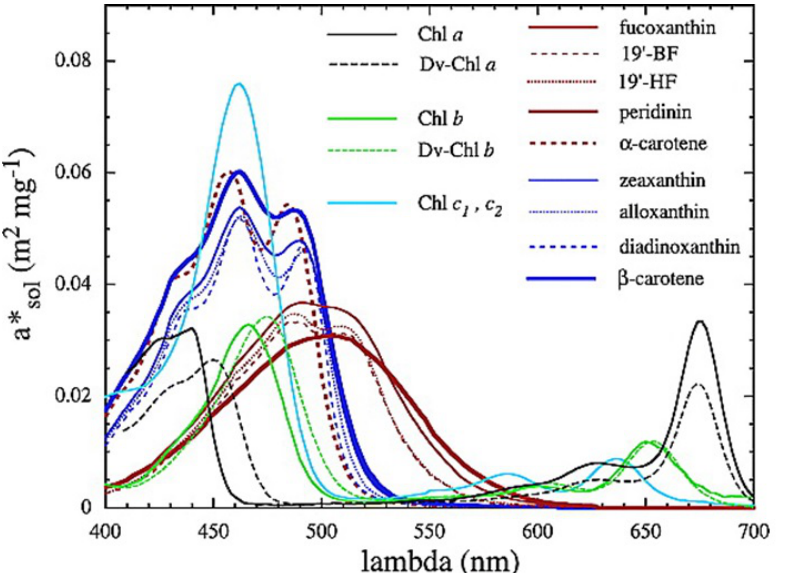
( λ ) (in m 2 mg − 1 ), sol , i